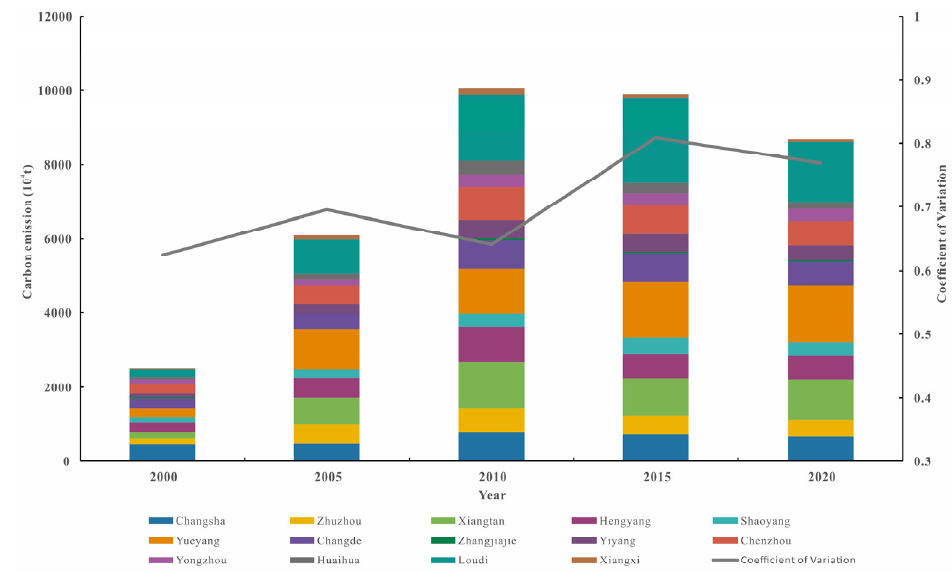
Figure 2. Characteristics of carbon emissions of each city in Hunan Province from 2000 to 2020.